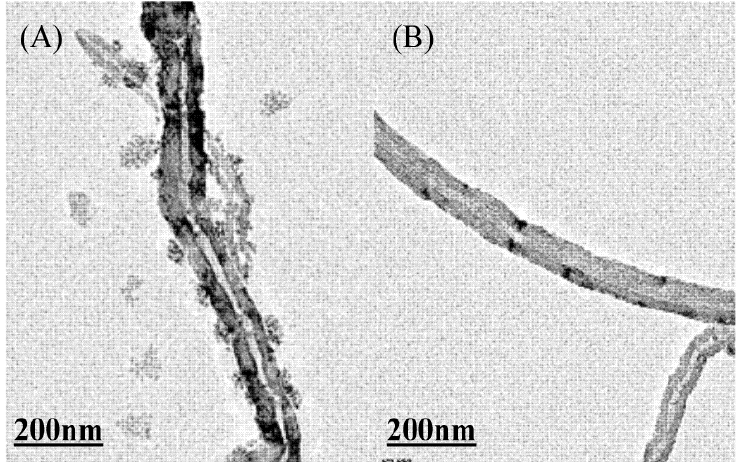
Figure 1. The TEM images of (A) CNTs/AuNPs composite and (B)